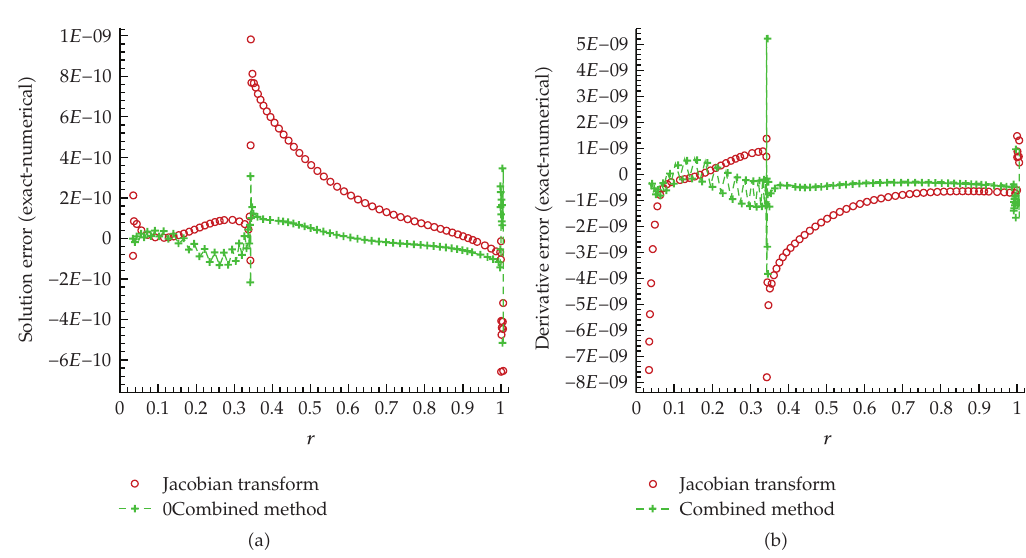
Figure 7: Comparisons of the error in solution φ (cid:6) a (cid:7) and the derivative of the solution ∂φ/∂r (cid:6) b (cid:7) for the sample geodynamo problem. Results were obtained separately from the sixth-order compact schemes with the Jacobian transformation and the combined method at L (cid:9) 2. The total number of grid points in three subdomains is